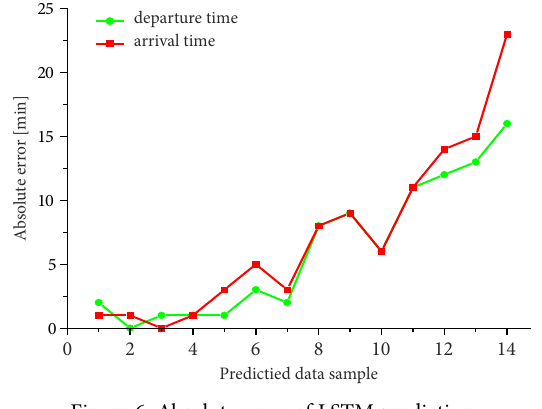
Figure 6. Absolute error of LSTM prediction